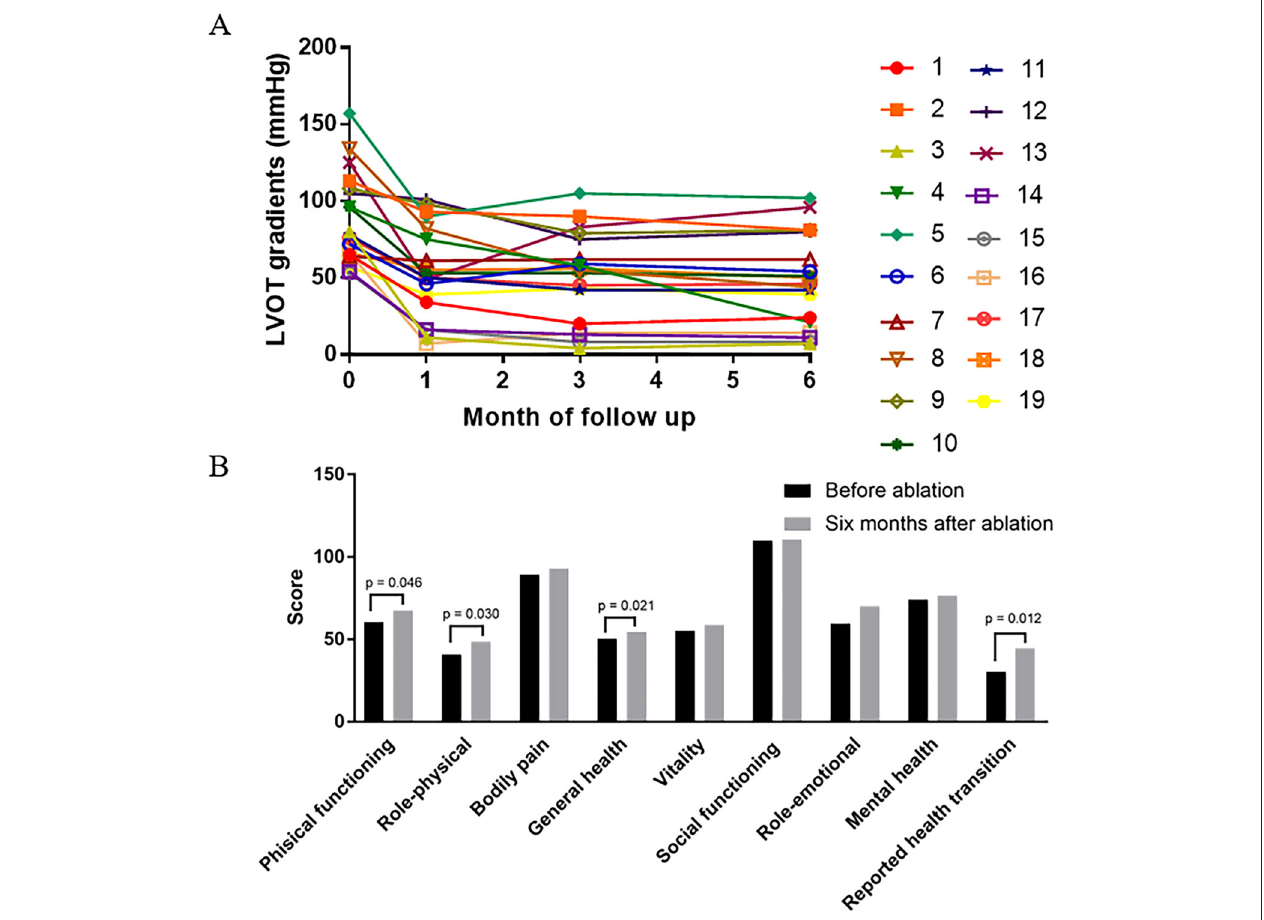
FIGURE 5 | The change of hemodynamic and health-related quality of life after 6 months follow up. (A) LVOT gradient is shown (in mmHg) before, 1 month after, 3 months after, and 6 months after LV septal radiofrequency ablation. Reduction of gradient is significant after 6 months follow up ( p < 0.001) especially in patient 3, 4, 8, 14, 15, and 16. (B) Comparison of health-related quality of life before and 6 months after ablation procedure. The score of four dimensions (physical functioning, role-physical, general health, and reported health transition) are increased after 6 months follow